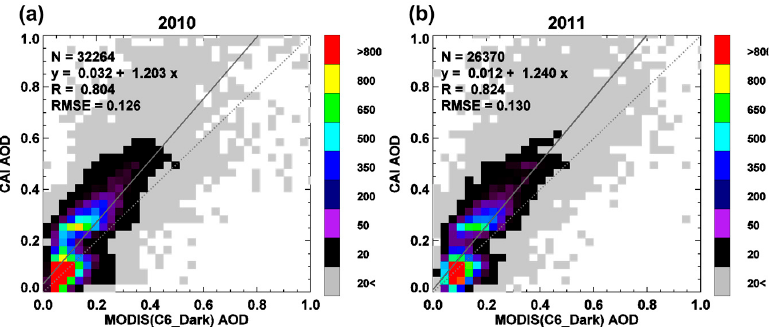
Figure 1. Comparisons of retrieved AOD from MODIS and TANSO-CAI over ocean in: ( a ) 2010; and ( b ) 2011. Colors represent the frequency of compared results.